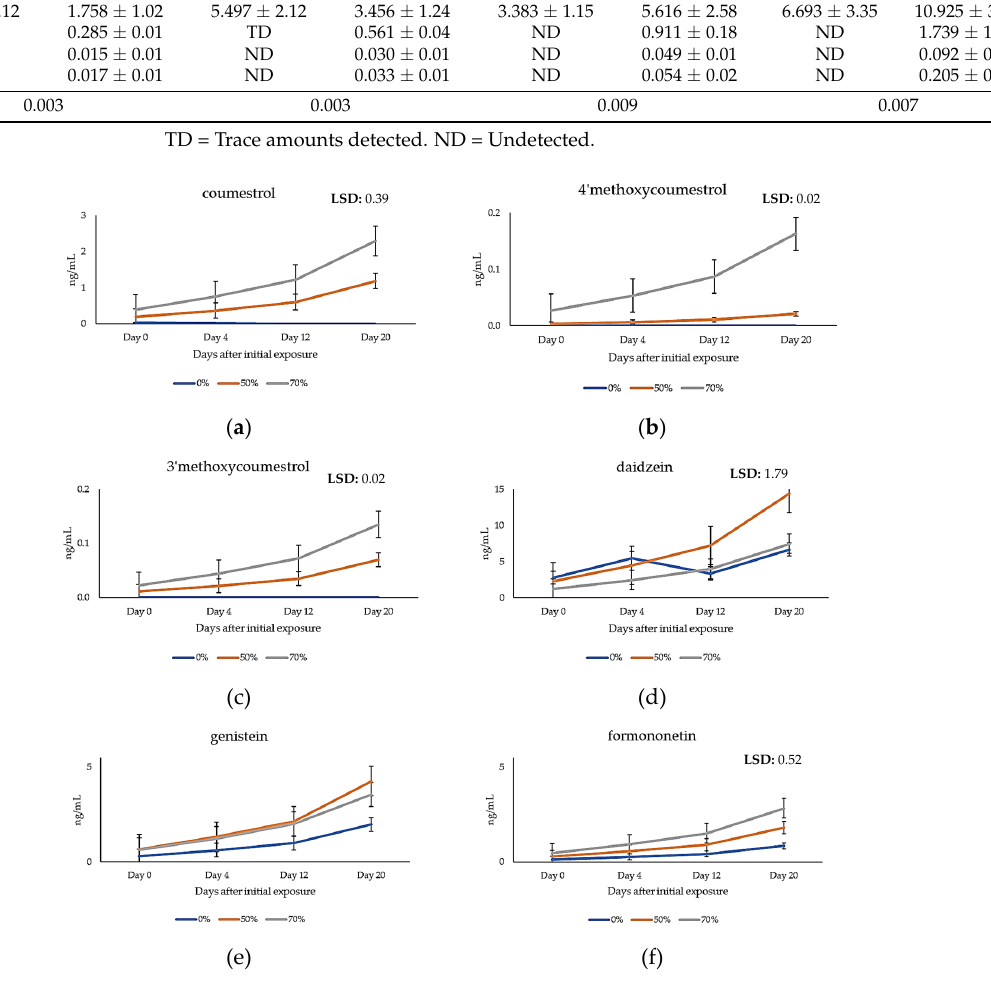
Figure 6. The average concentration of accumulated: ( a ) coumestrol; ( b ) 4 ′ methoxycoumestrol; ( c ) 3 ′ methoxycoumestrol; ( d ) daidzein; ( e ) genistein; and ( f ) formononetin; in the plasma (ng·mL − 1 ) of the control (ryegrass) and two lucerne treatment groups (1. 50% lucerne stands; and 2. 70% lucerne stands) over four sampling times during a 21-day period.